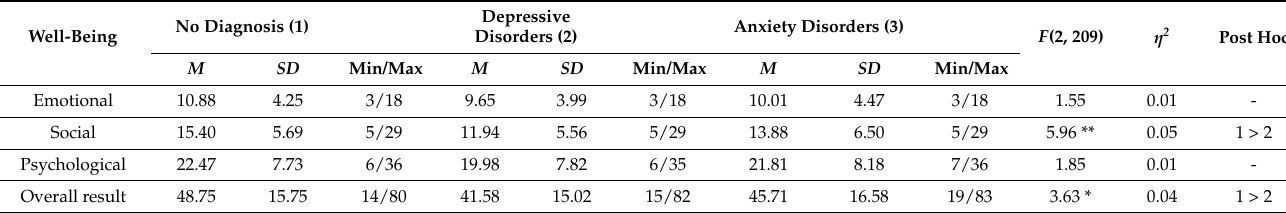
Table 3. Analysis of variance in intergroup scheme of well-being between healthy participants, participants with depression, and participants with anxiety disorders ( n = 70 in each group).